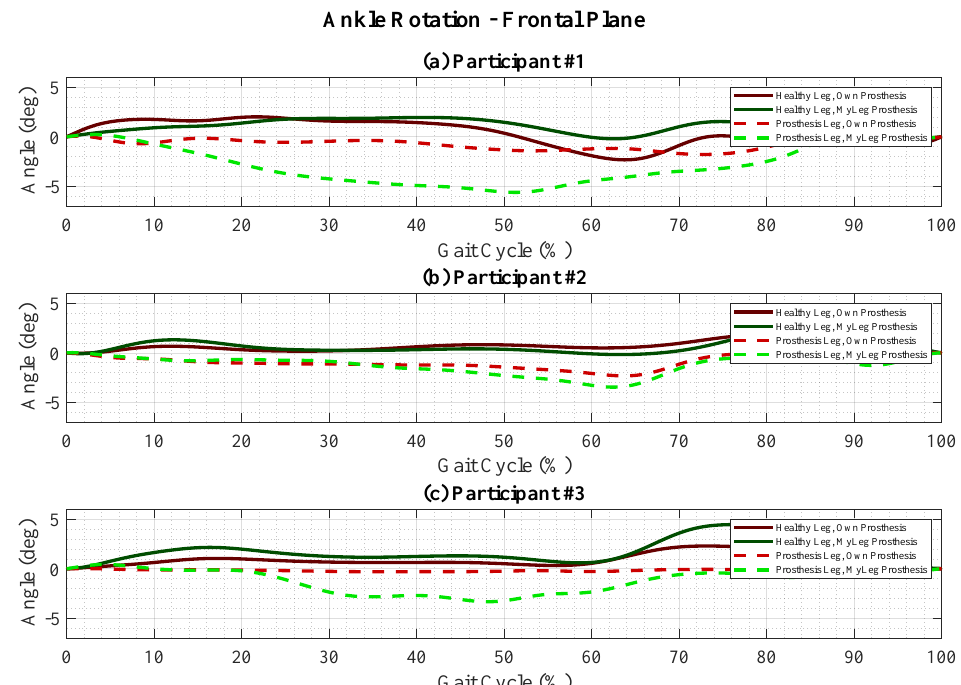
Figure 13. The eversion(+) and inversion( − ) during gait cycle of ( a ) Participant 1, ( b ) Participant 2 and ( c ) Participant 3: healthy leg, using their own prosthesis (dark red straight line); healthy leg, using MyFlex- δ (light red straight line); prosthetic leg, using their own prosthesis (dark red dashed line); prosthetic leg, using MyFlex- δ (light red dashed line).